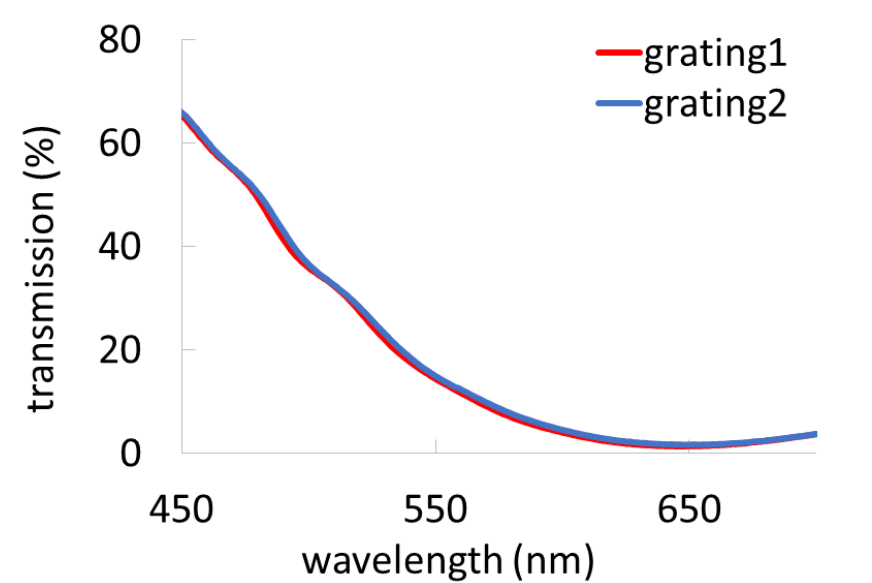
Figure 4. Zero-order transmission spectrum for two LC geometric phase gratings.